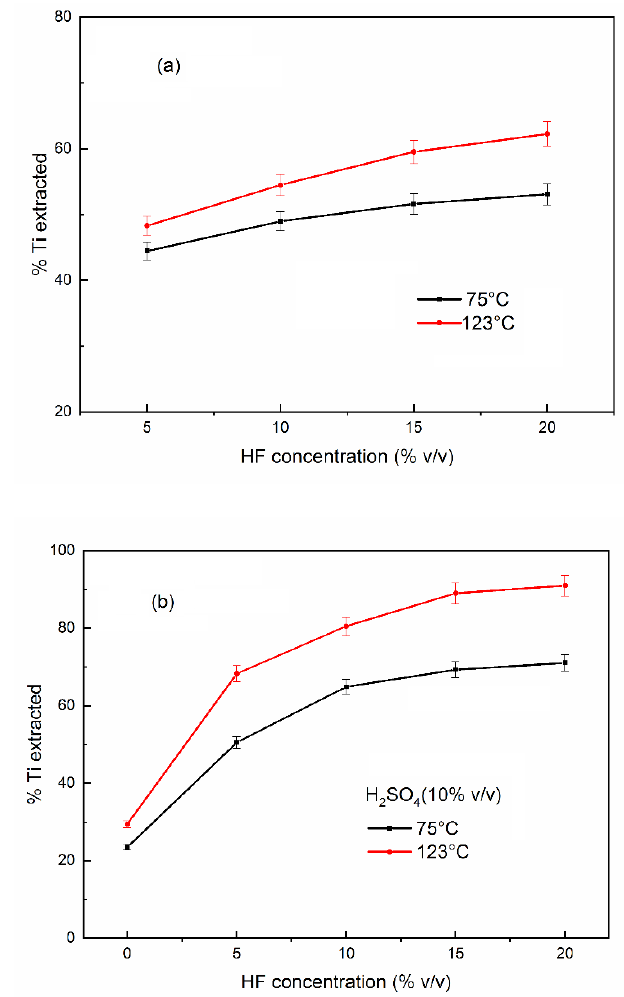
Figure 6. Effect of the concentration of the leaching medium at 75 and 123 °C: ( a ) HF; ( b ) H 2 SO 4 (10%